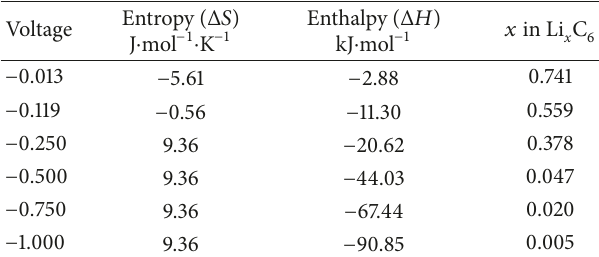
Figure 2: Plot of temperature (K) versus OCV for equilibration times.